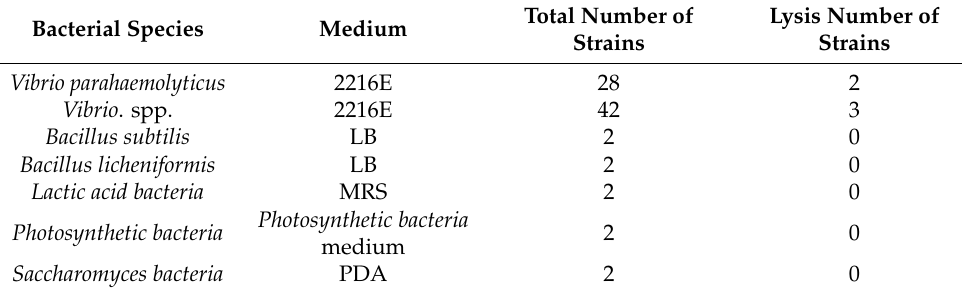
Table 4. Host ranges of phage PVA23 to other Vibrio strains.